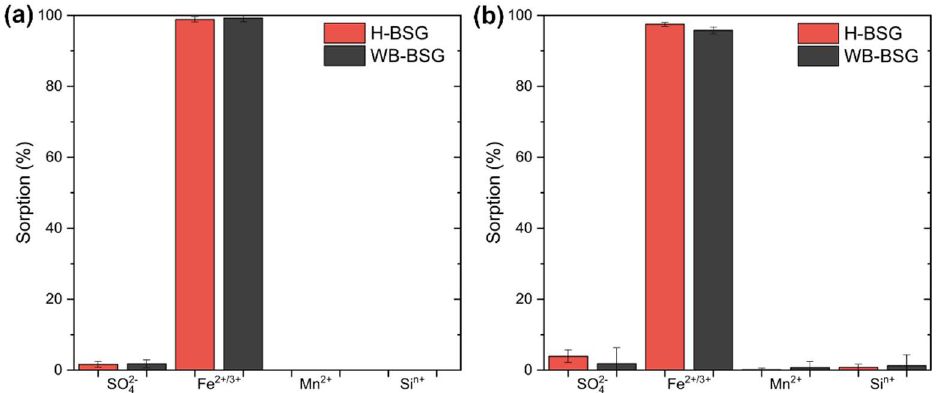
Figure 10. Adsorption efficiency of different ions from real water samples onto BSG, averages of six batches with standard deviation as error bars. Batch experiments performed with real water samples from two locations ( a , b ) and 3.33 g/L dosage of H-BSG (red) or WB-BSG (grey) for 24 h at r.t. Real wa- ter ( a ) contained 18.850 mmol/L SO 42 − , 0.005 mmol/L Fe 2+/3+ , 0.002 mmol/L Mn 2+ , 0.176 mmol/L Si and had a pH 0 from 6.98, while real water ( b ) had 3.958 mmol/L SO 42 − , 1.612 mmol/L Fe 2+/3+ , 0.048 mmol/L Mn 2+ , 2.182 mmol/L Si and a pH 0 from 3.1. The exact numeric values can be seen in Table S10.